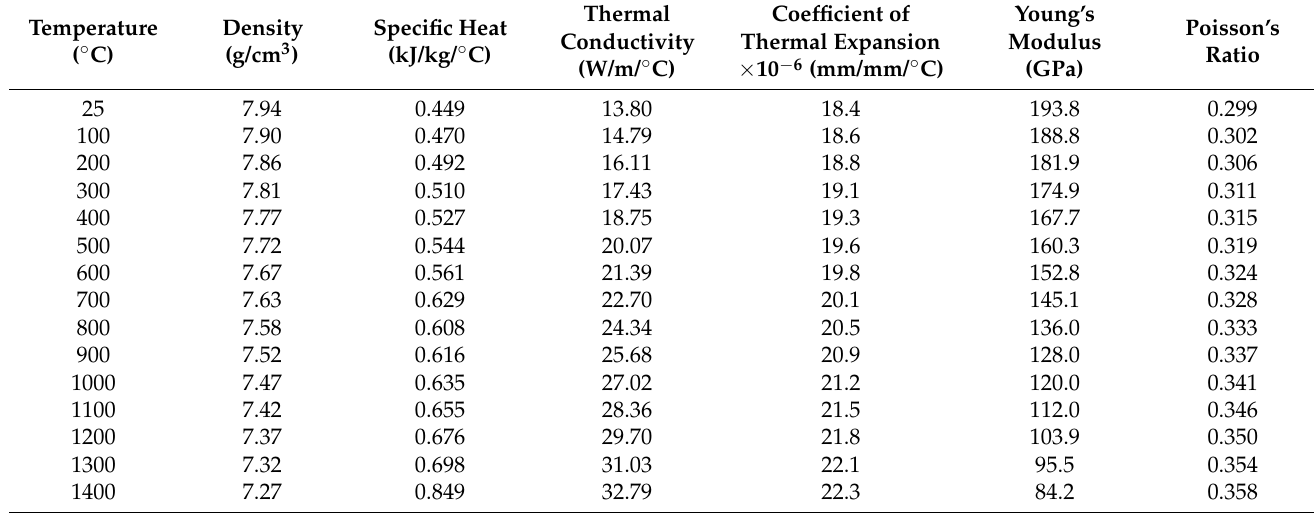
Table 12. Thermo-physical properties data of ER309L.